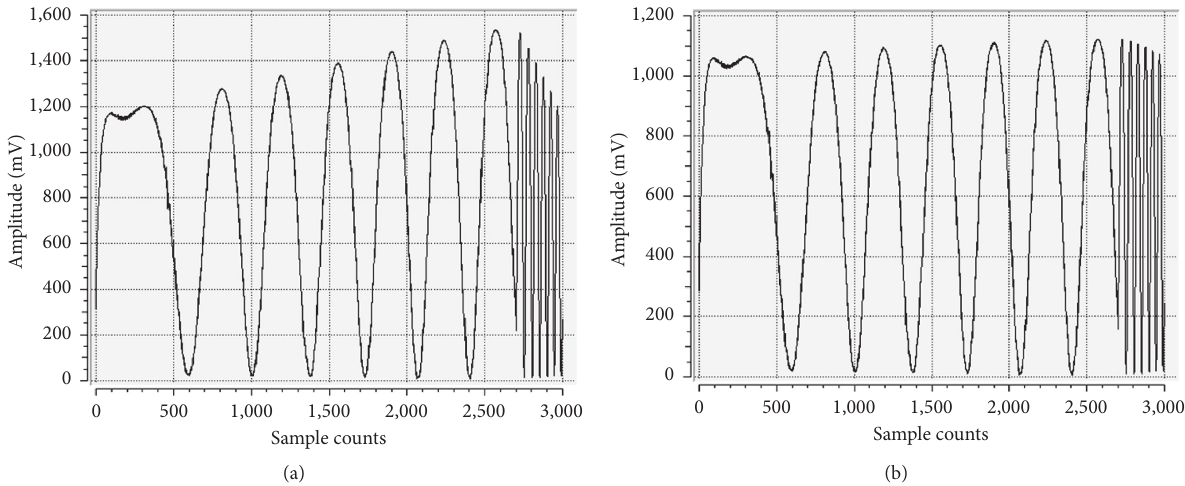
Figure 5: Amplitude correction of the acquired signal. (a) Original signal. (b) Amplitude corrected signal.